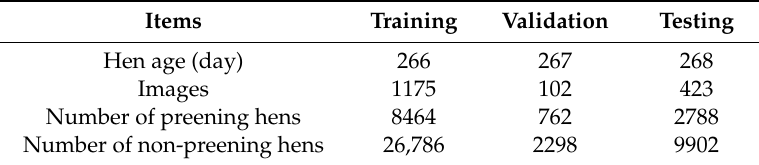
Table 1. Data distribution for training, validation and testing.